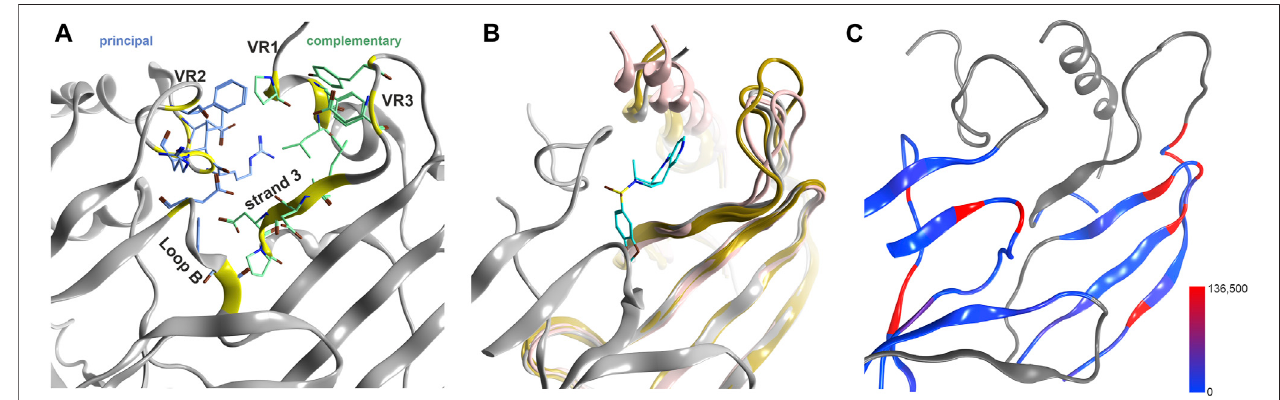
FIGURE 3 | Novel binding site at the upper ECD interface of GlyR α 3. (A) the binding site from 5TIO with pocket forming segments labeled (see Supplementary Figure S4 for the topology) and amino acids displayed in stick rendering. (B) 5TIO (in grey) with the ligand AM-3607 bound at the novel pocket in superposition with closely homologous proteins glycine α 2(5BKF chainD ingold), glycine β (5BKF chain Einblue), GABA A α 1(6X3V chain Bin pink) and GABA A β 2(6X3VchainCin red)at thecomplementarysubunittoshowthestructuralvariabilityinVR3. (C) Amountofvariantsacrossallgenesofinterestintheregionofthisbindingsitemappedonto 7EKT. Ribbon heatmap represents the sum of minor allele counts per 100,000 at each aligned position. Variable regions, where the 44 subunits cannot be aligned to a single reference structure, are shown in